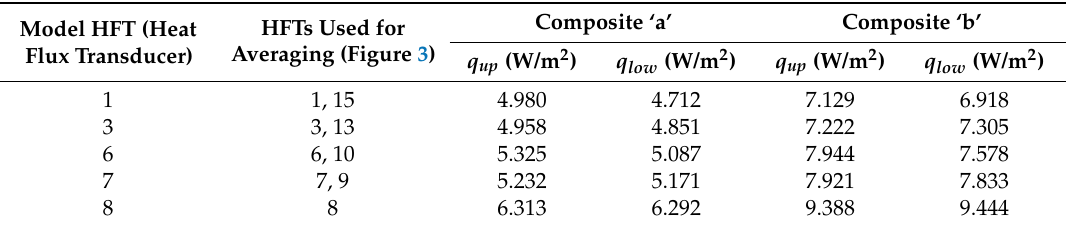
Table 2. Average measured heat fluxes from composite ‘a’ and ‘b’ used for estimating effective edge conductivities.